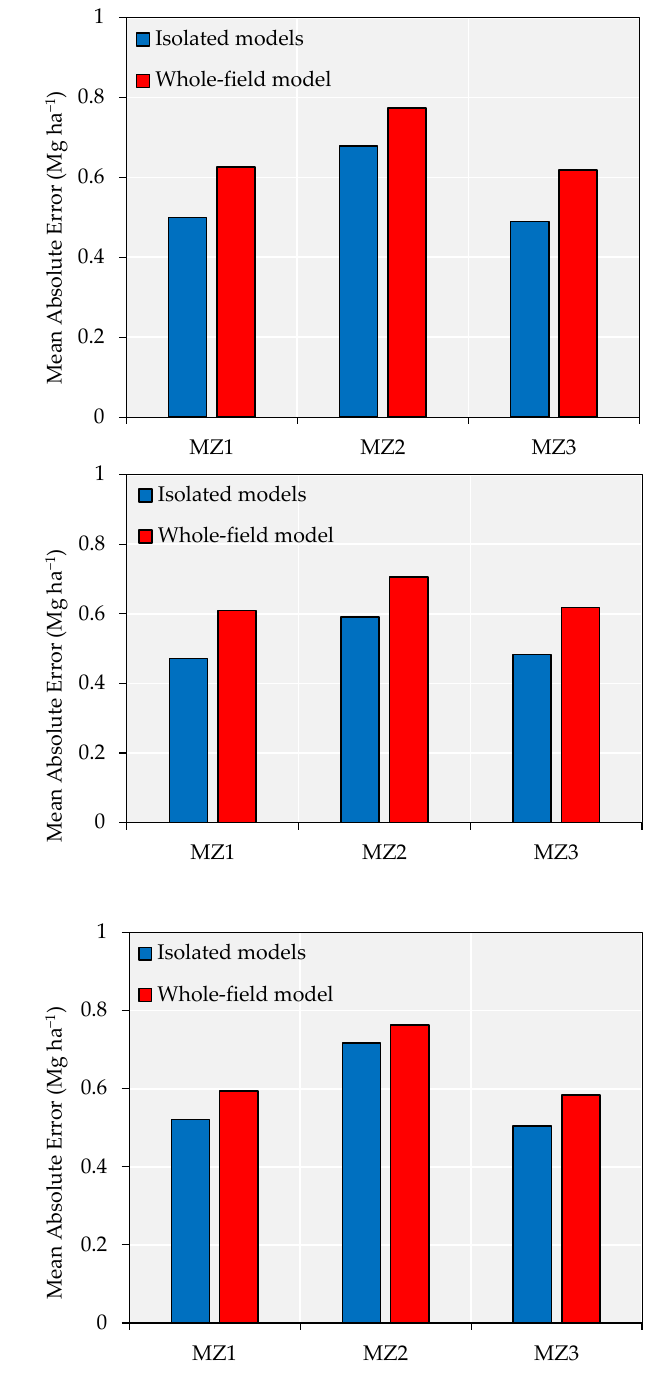
Figure 10. Comparison between the accuracy of the whole-field model and specific models for each management zone in three scenarios (all years combined, 2018 and 2019 season). MZ1, MZ2, and MZ3: management zones one (high yield), two (low yield) and three (intermediate yield),